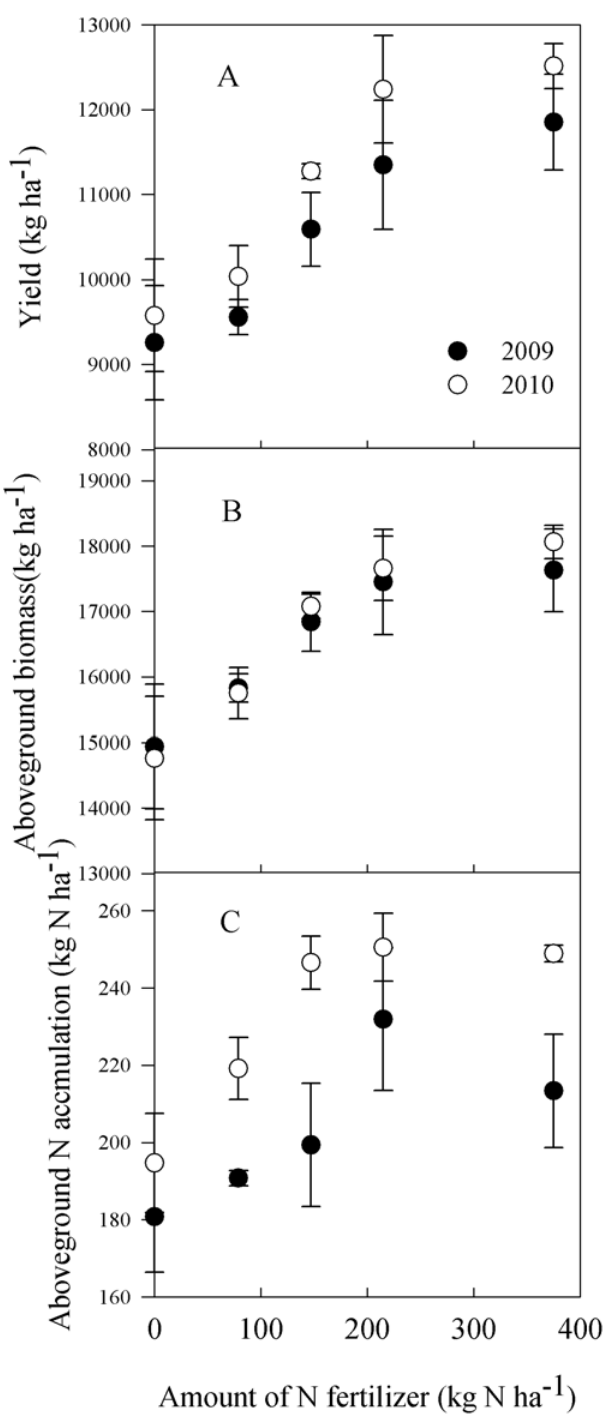
Fig 6. Maize grain yield, aboveground biomass and aboveground N accumulation of maize in five N treatments in 2009 and 2010. Each point is the mean of 4 replicated plots. Error bars represent ± SE.